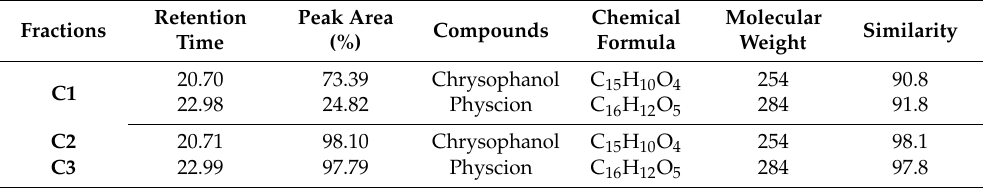
Table 1. Bioactive compounds identified in EtOAc extract of Rumex crispus root by